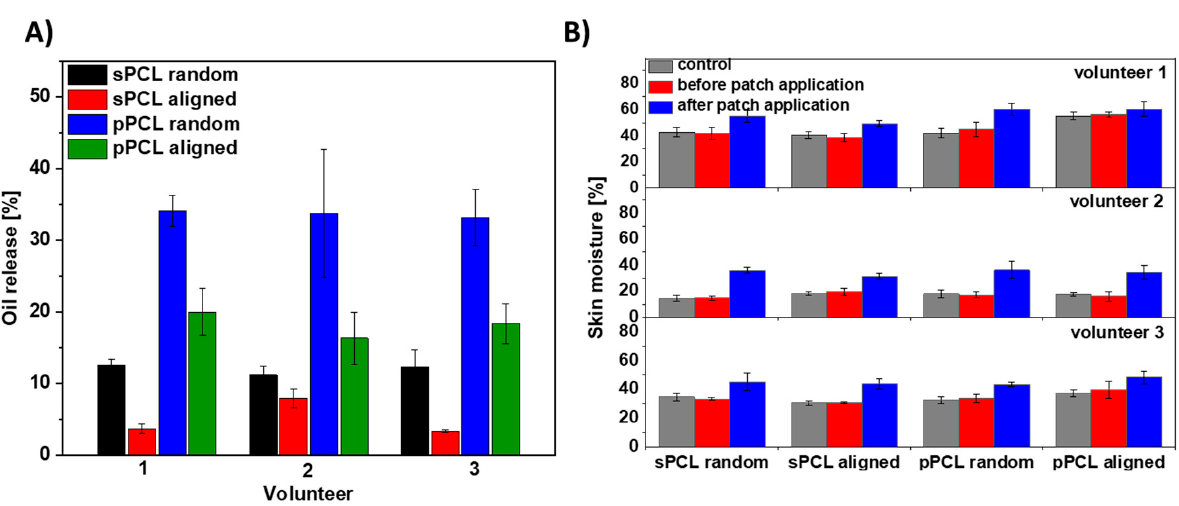
Figure 6. The oil test release on three volunteers’ skin ( A ) from all four types of PCL membranes: random and aligned sPCL and pPCL fibers within 6 h and ( B ) skin moisture before and after the patches’ application. The control samples are the PCL patches without the oil with the skin moisture data after the patch removal as before their application the skin moisture were at the similar levels.